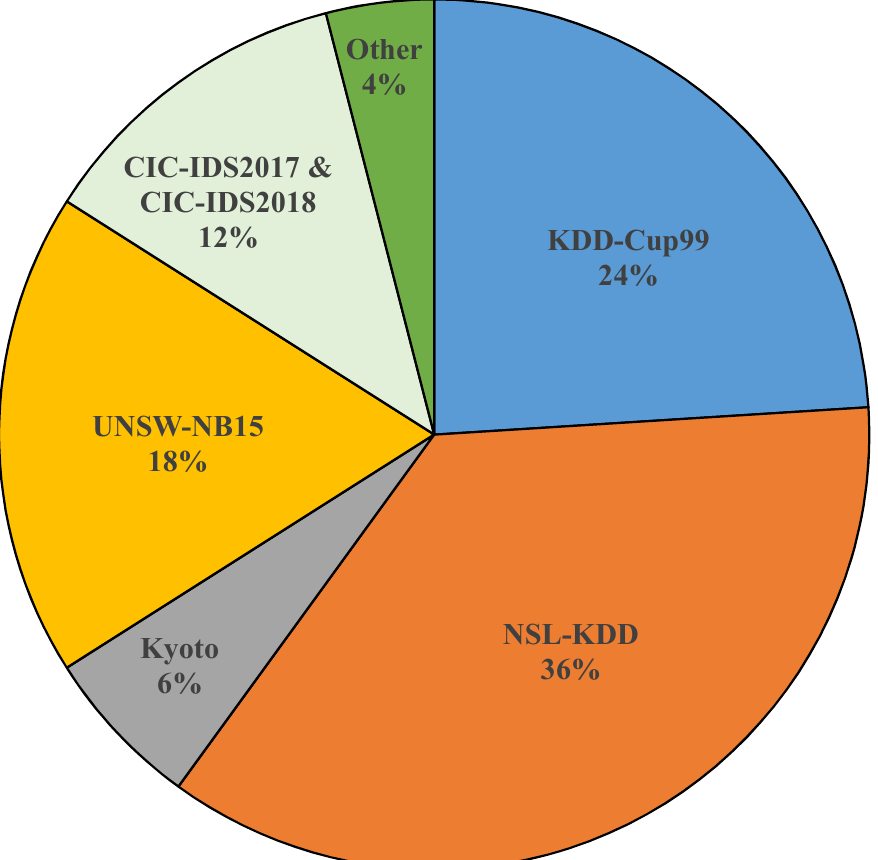
Figure 1. Statistics on the percentage of research on published datasets in the field of anomaly-based network intrusion detection system